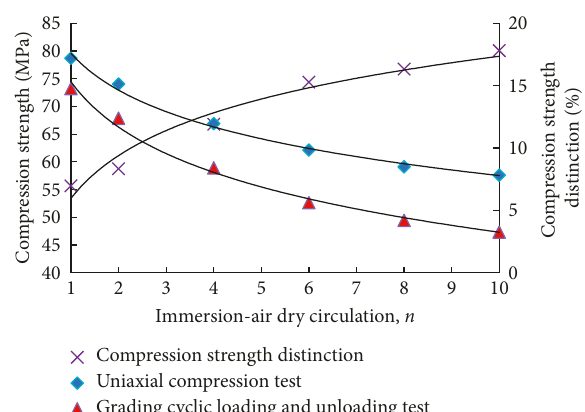
Figure 7: The compressive strength deterioration curve of rock sample under water-rock